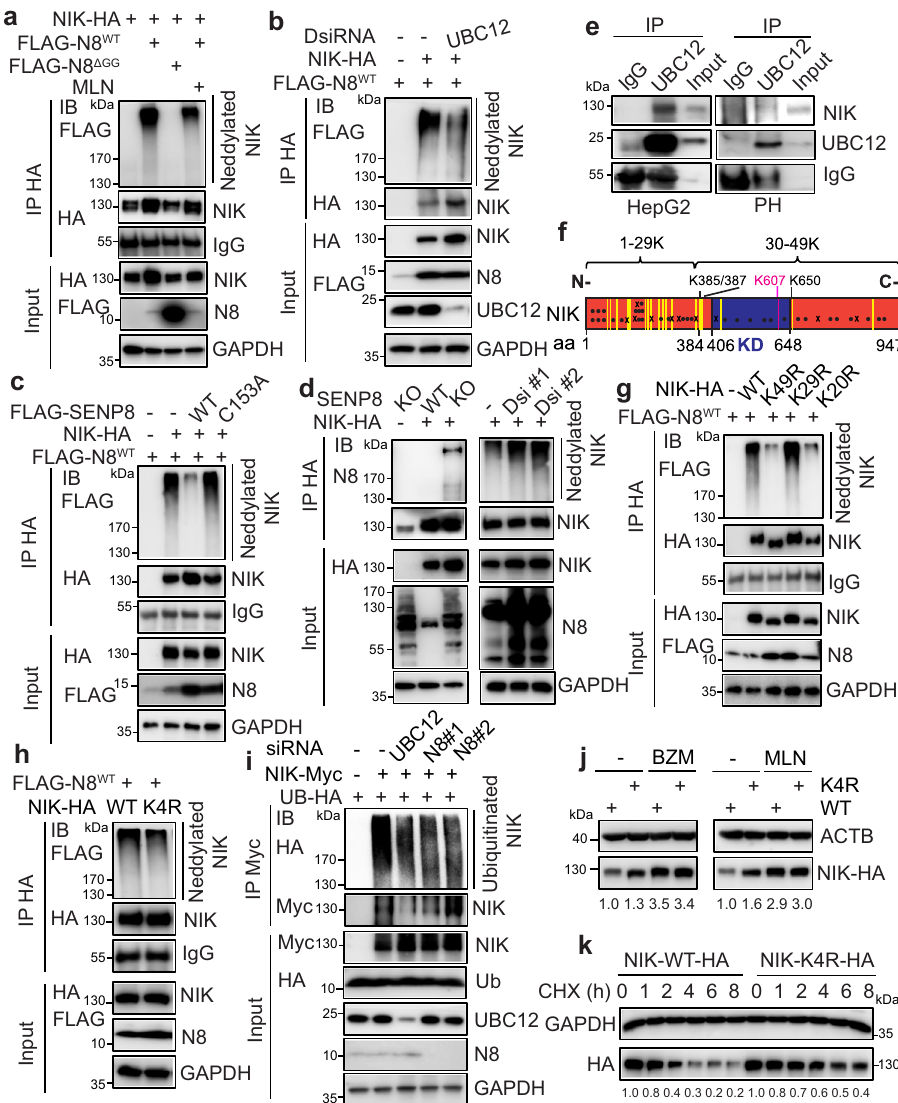
Fig. 7 | NIK is neddylated and neddylation promotes its ubiquitination and degradation.a Twenty-fourhoursaftertransfectionwiththeindicatedconstructs, HepG2 cells were treated with or without 2.0 µ M MLN for 24h. The neddylation of NIK-HAwas examined by IB after denaturing IP. Cell lysates were IB as input. N8 WT , wild-type NEDD8; N8 Δ GG , conjugation-de fi cient NEDD8 mutant. b The neddylation ofNIK-HAwasexaminedbyIBafterdenaturingIPin293Tcellstransfectedwiththe indicated constructs with scrambled DsiRNA or DsiRNA against UBC12. c , d NIK neddylation was assessed after denaturing IP in ( c ) 293T cells overexpressing SENP8 WT and C153A mutant, ( d ) WT and SENP8-KO MEFs, and 293T cells with SENP8 knocked down. Cells were co-transfected with indicated NIK-HA and/or FLAG-N8 WT . e Western blot after IP with an anti-UBC12 antibody or a control IgG antibodyinHepG2andprimaryhepatocyte(PH)lysatestreatedwithBZM(100nM, 12h). f AschematicdiagramofthelysinesitesonNIKisshown.·:conserved,x:non- conservedlysines.Yellowlinesindicatelysineresiduespreviouslyidenti fi edwithK- Ɛ -GG remnants. Catalytic kinase domain (KD): 405-646 amino acids (aa).